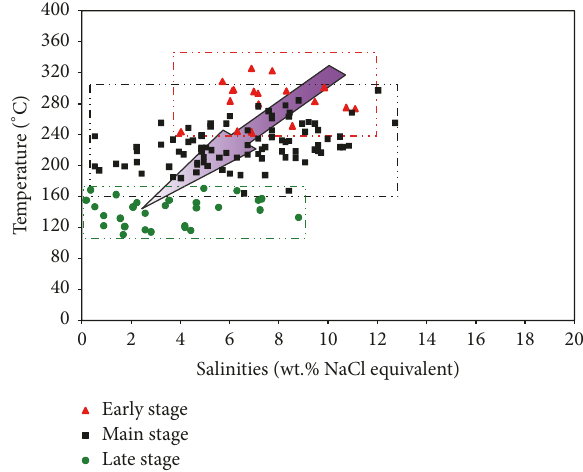
Figure 16: Homogenization temperature versus salinity plot of fluid inclusions showing fluid evolution in the Zhijiadi